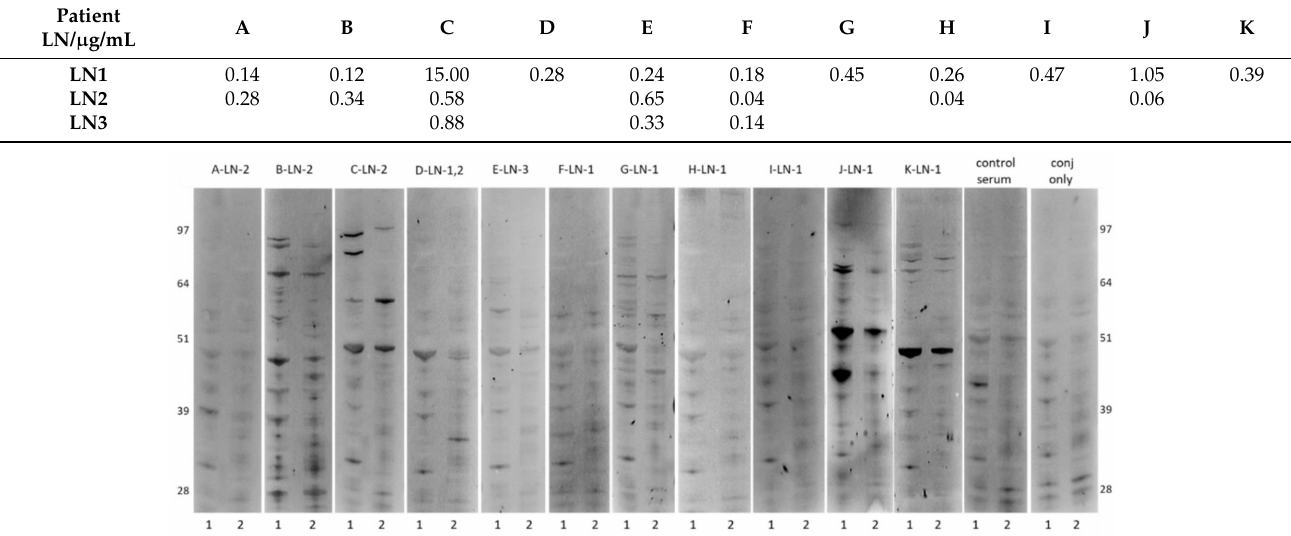
Table 1. IgG concentration ( µ g/mL) of ASC probes isolated from 11 ovarian cancer patients (columns A–K), separated by individual lymph node sources.